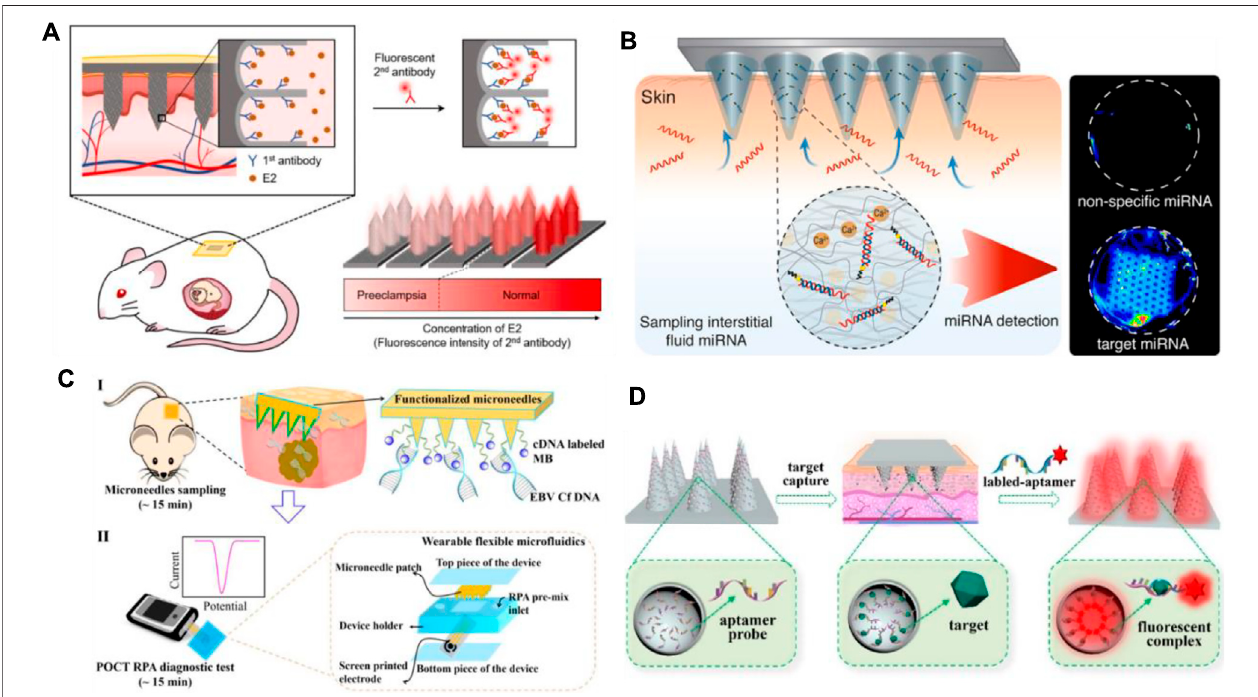
FIGURE 3 | (A) Schematic diagram of immuno-functionalized MN patch for PE diagnosis by detecting E2 biomarker at the sub-nanogram level. Reproduced with permission (Kang et al., 2020). Copyright 2020, Elsevier. (B) Schematic representation of the hydrogel-coated microneedle platform during sampling of the interstitial fl uid. Reproduced with permission (Al Sulaiman et al., 2019). Copyright 2019, American Chemical Society. (C) Schematic work fl ow of the assay, with MN patches sampling(I)andaPOCT electrochemicalmicro fl uidicplatform(II).Reproduced withpermission(YangB.et al.,2019).Copyright2019,AmericanChemicalSociety. (D) Schematics of an aptamer-decorated porous MN array. The biomarkers could be captured by probes on the MNs. Reproduced with permission (Yi et al., 2021). Copyright 2021,